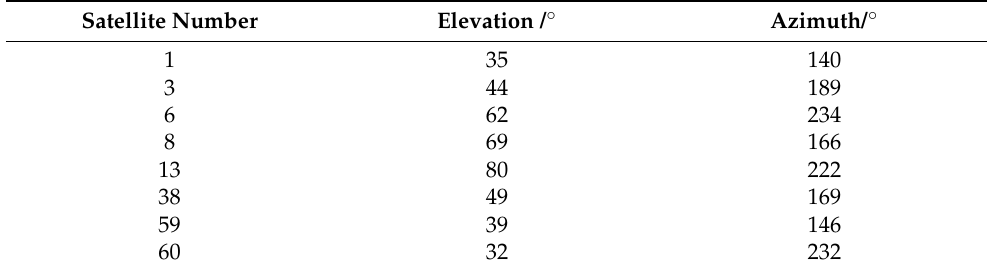
Table 3. Position information of eight satellites.